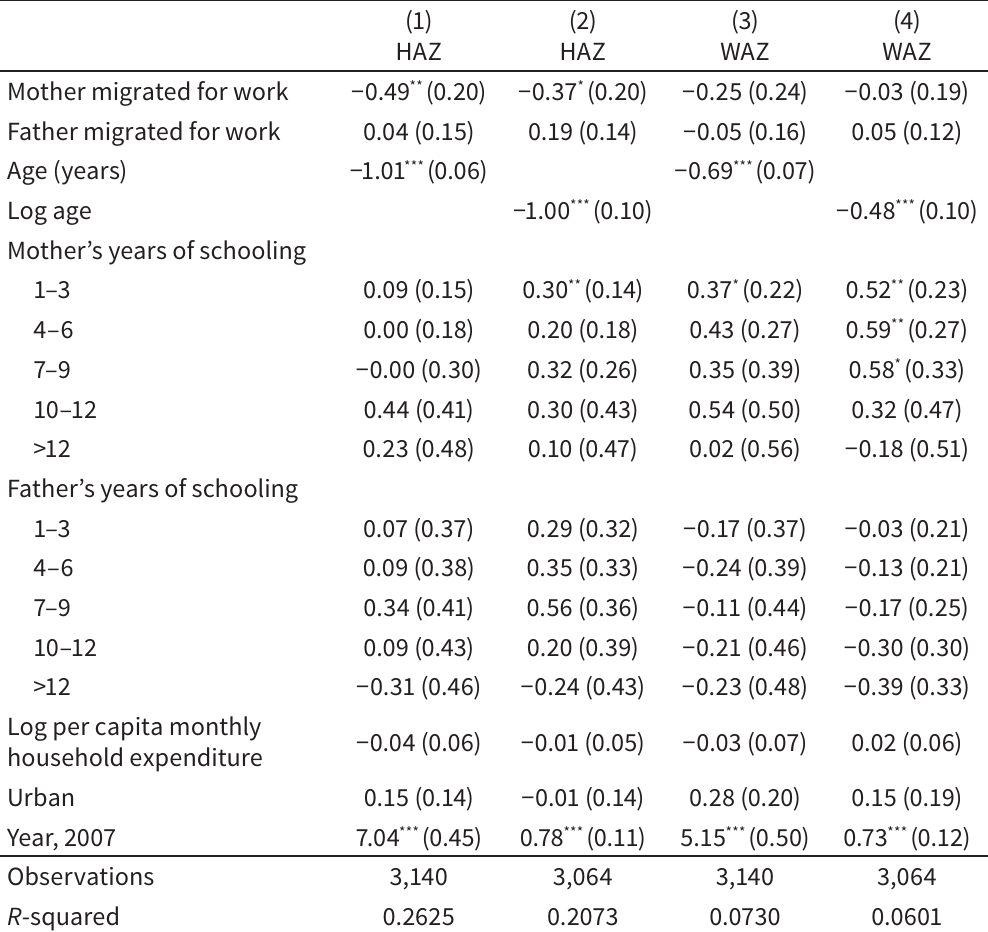
Main regression results